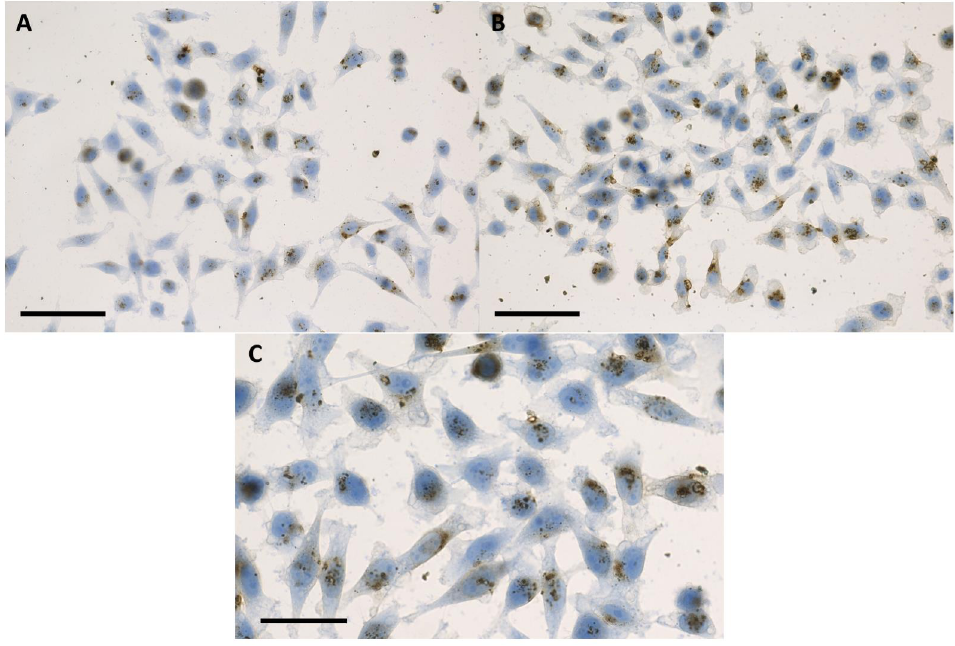
Figure 1. Bright-field microscopy images of human cervical adenocarcinoma (HeLa) cells at 24 h following 16 h of incubation with 100 μg/mL ( A ), and 200 μg/mL ( B ) IONP DOX ; blue hematoxylin, dark brown IONP; the scale bar is 50 μm; ( C ) detailed image of HeLa cells at 24 h following 16 h of incubation with 200 μg/mL IONP DOX ; the scale bar is 25 μm.